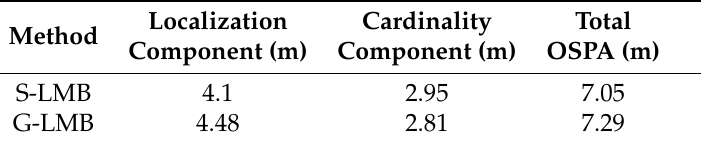
Table 3. Average OSPA distances for the S-LMB-GOM filter and the G-LMB-GOM filter.